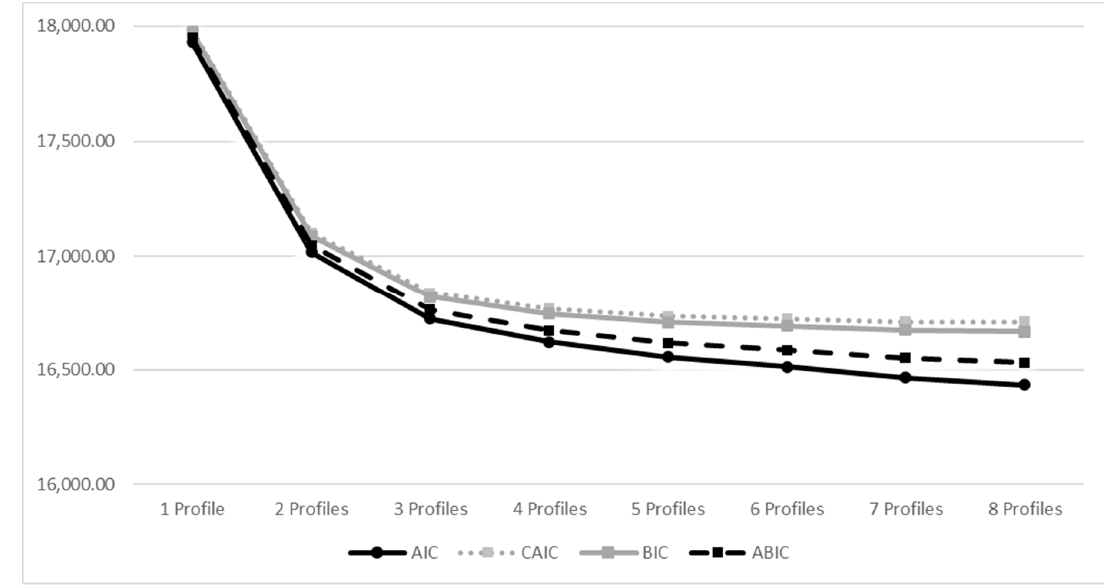
Figure 2. Elbow plot of the information criteria.